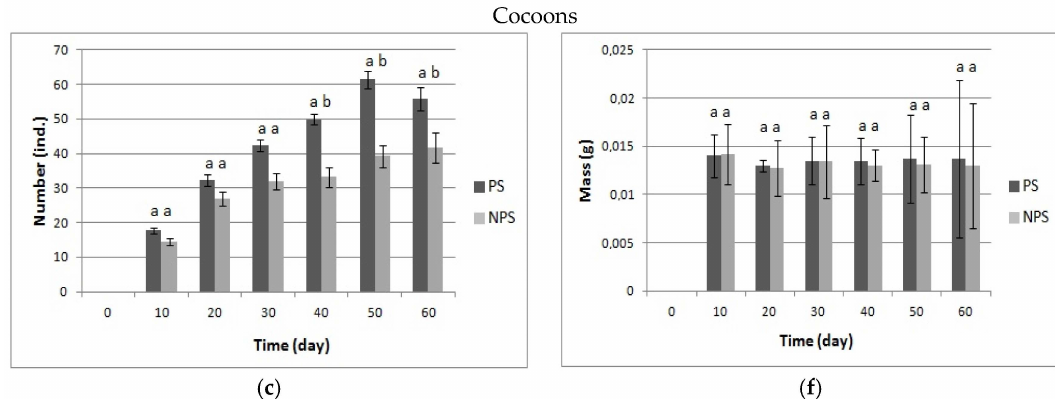
Figure 3. Cont . Figure 3. Dynamics of the mean number and mean biomass (g) of adult specimens ( a , d ), immature specimens ( b , e ) and cocoons ( c , f ) of E. fetida in the process of vermicomposting sugar beet pulp in modified vermireactors. Values designate the mean ± standard deviation based on 5 samples. Mean values with di ff erent letters are statistically di ff erent ( p < 0.05).